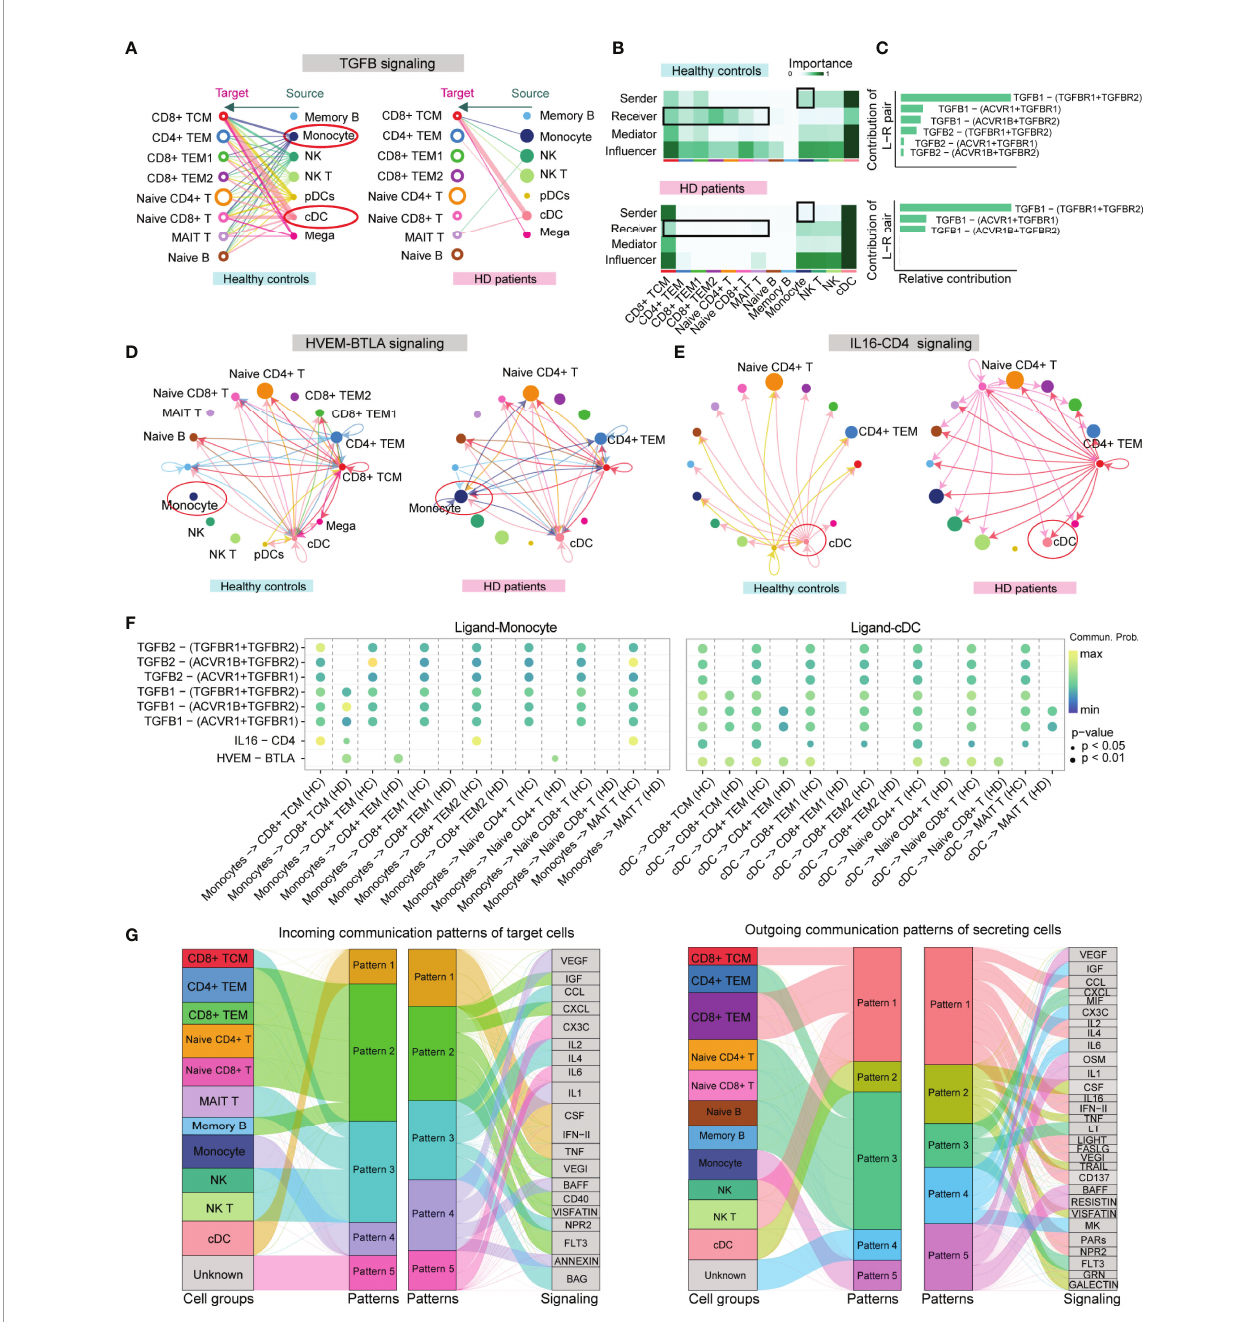
FIGURE 4 | CellChat analysis of the communication between PBMC subpopulations in HD patients. (A) Hierarchical plot showing the inferred cell-cell communication network for TGFB signaling. Open and solid circles denote target (receptor) and source (ligand), respectively. Edge width represents the communication probability. (B) Heatmap showing the relative importance of each PBMC subpopulation based on the computed four network centrality measures (sender, receiver, mediator, and in fl uencer) of the TGFB signaling network. The color bar represents important values. (C) The relative contribution of each ligand-receptor pair to the overall communication network of the TGFB signaling pathway. (D) The inferred HVEM-BTLA signaling network in HD and HC groups. Arrows show signal transmission direction from the source to the target. (E) The inferred IL16-CD4 signaling network in HD and HC groups. (F) Comparison of the signi fi cant ligand-receptor pairs of TGFB, BTLA, and CD4 signaling pathways between the HD and HC groups, which contributes to the signaling from APCs (DC and monocyte) to T cell subpopulations. The color bar re fl ects communication probabilities. Dot size represents P values. A P- value is computed from a one-sided permutation test. (G) Alluvial plots show the incoming signaling patterns of target cells (left) and the outgoing signaling patterns of secreting cells (right) in HD patients. The thickness of the fl ow represents the contribution of the cell group or signaling pathway to each corresponding pattern. PBMC, peripheral blood mononuclear cell; APCs, antigen-presenting cells; cDC, conventional dendritic